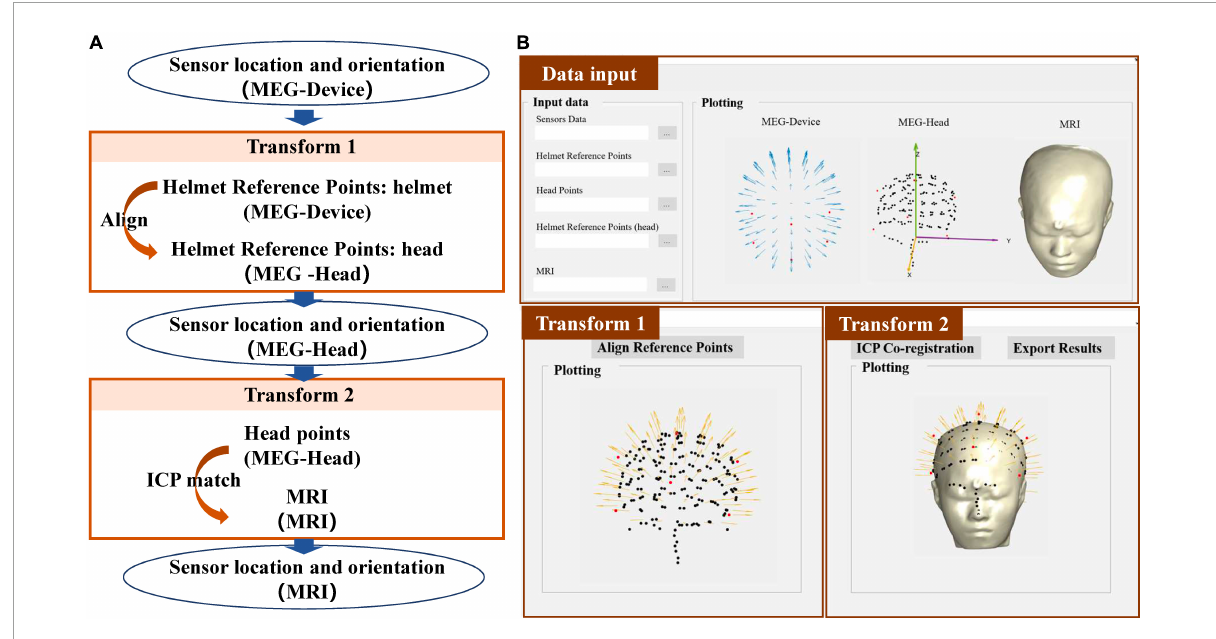
FIGURE2 (A) Workflow of the co-registration of OPM-MEG and MRI using Fastrak; (B) integrated interface for